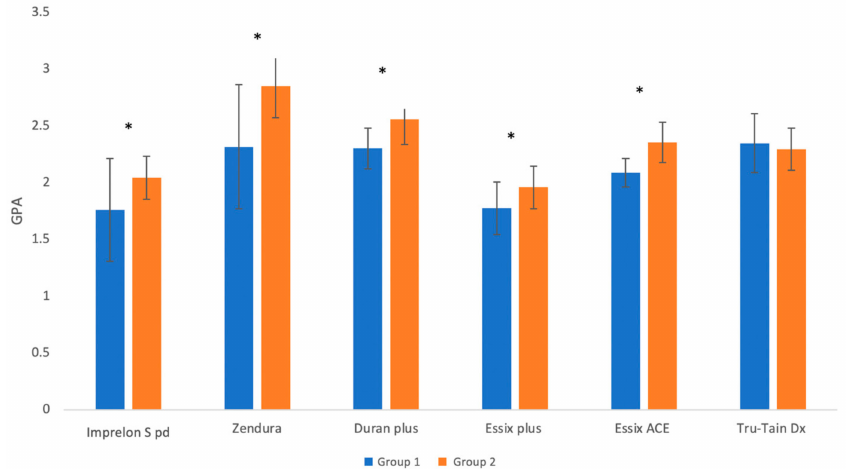
Figure 7. Mean ± SD of flexural modulus values of Group 1 and Group 2 (the * symbol indicates a significant difference between the two groups for the same material at p < 0.05